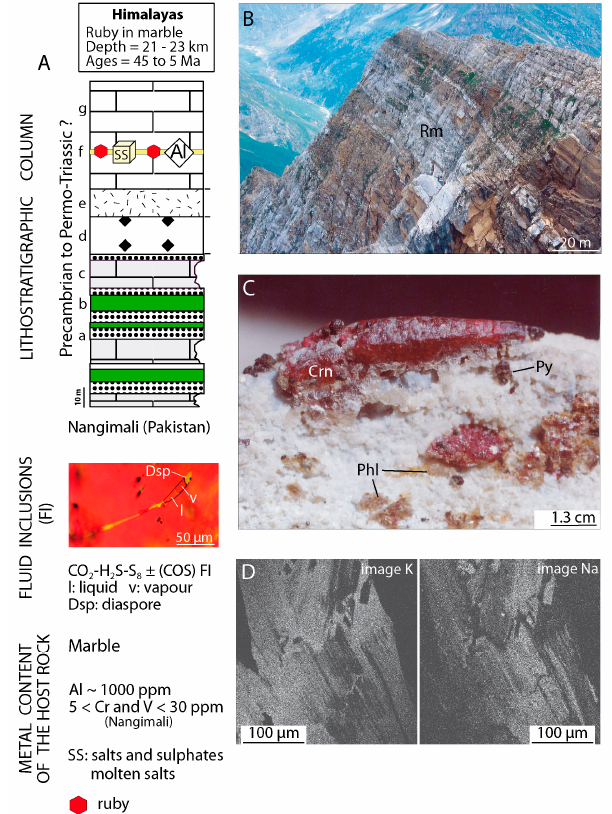
Figure 34. Ruby in metamorphosed carbonate platforms from Central and South-East Asia. ( A ) The Nangimali formation, Pakistan, showing the location of the ruby deposit in the metamorphic